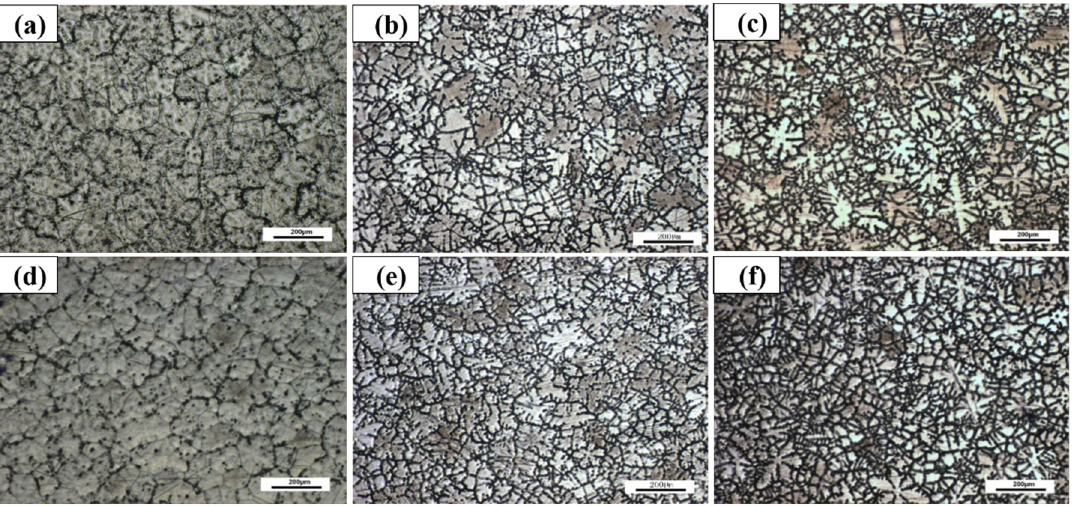
Figure 11. Optical microstructure from the top, middle, bottom of as-cast ( a – c ) GWK-a and ( d – f ) GWK-c alloys after flammability test.